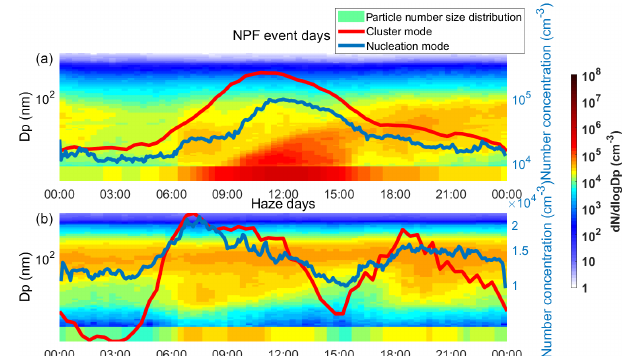
Figure 8. Median diurnal patterns of the particle number size distri- bution over the size range of 1.5–1000nm and number concentra- tions of cluster mode (red lines) and nucleation mode (blue lines) particles on the NPF event days (a) and haze days (b) . The time res- olution of every data point of particle number size distribution and cluster mode particle number concentration was 12min. The time resolution of every data point of nucleation mode particle number concentration was